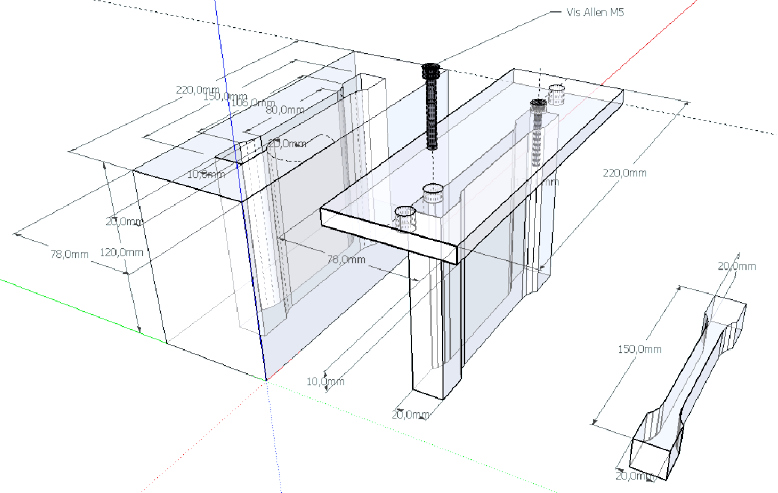
Figure 12. NF EN ISO 3167 1A specimen compression mold: